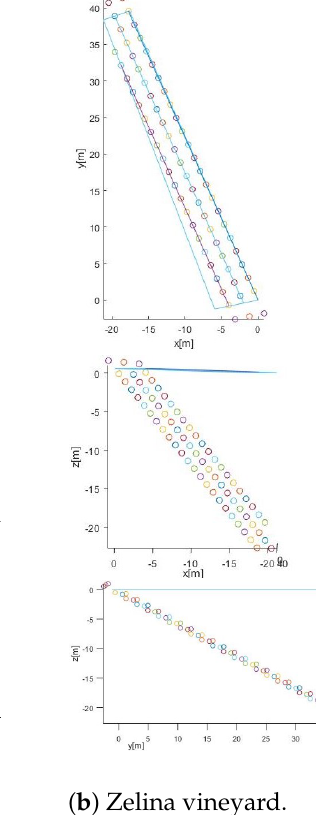
Figure 9. Topological 3D model of Jazbina ( a ) and Zelina ( b ) vineyards based on the coordinates of GPS shown in the caption of Figure